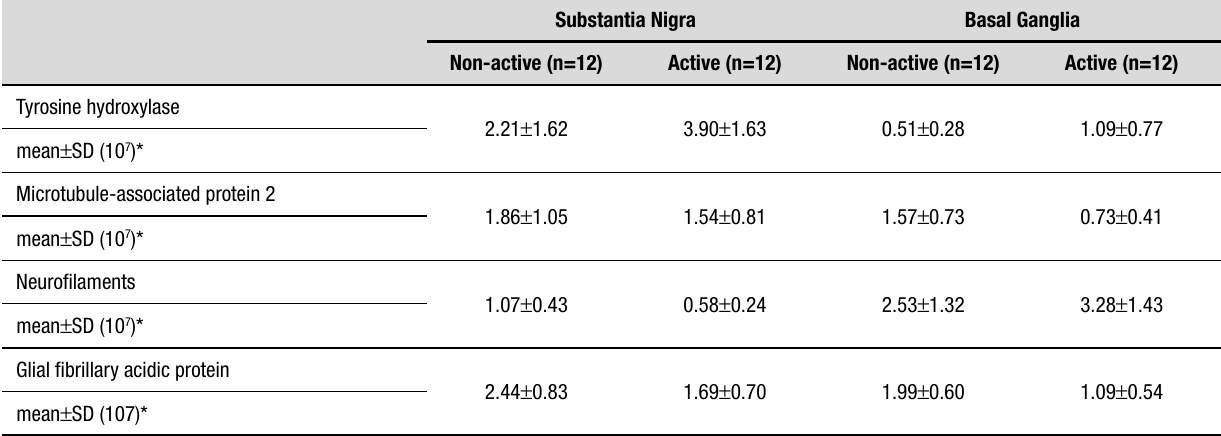
Table 2. Protein expression in the substantia nigra and basal ganglia according to physical activity status